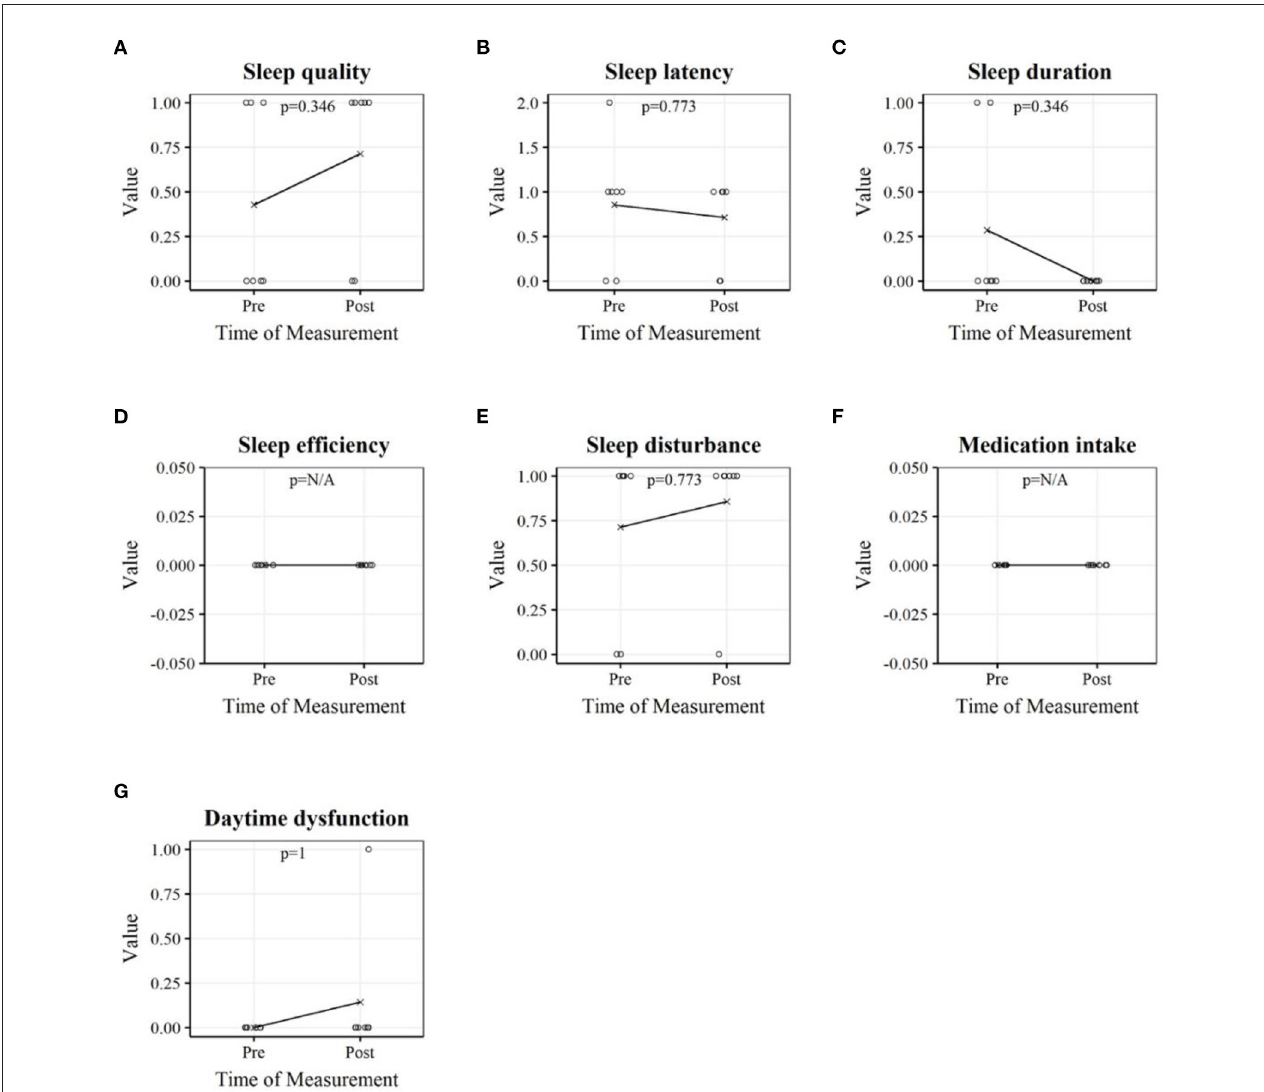
FIGURE 2 | Sleep variables of professional youth soccer players before and after the home training period. Each plot depicts the players’ individual measurements as well as the mean. Sleep quality (A) ; Sleep latency (B) ; Sleep duration (C) ; Sleep efficiency (D) ; Sleep disturbance (E) ; Medication intake (F) ; Daytime dysfunction (G) .